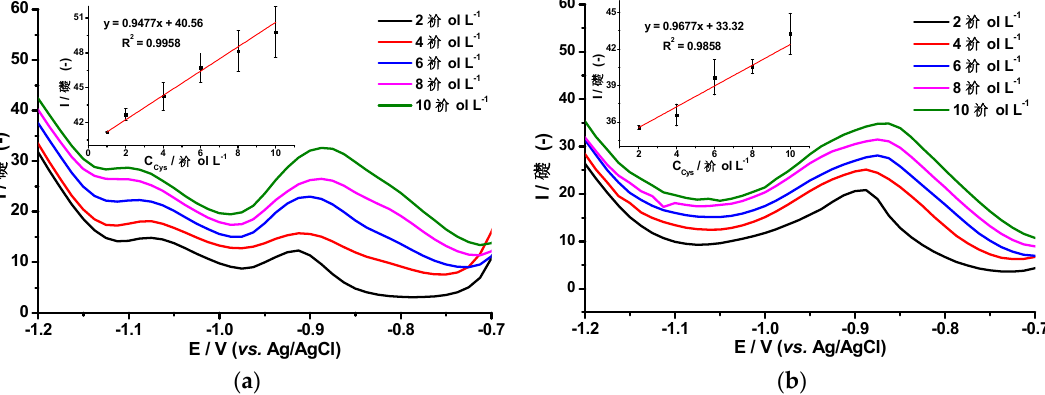
Figure 5. VPD responses of ( a ) AgHgNf/Cu electrode and ( b ) AgBiNf/Cu electrode in the Brdi č ka supporting electrolyte after addition of 2 to 10 µ mol L − 1 of l -cysteine. Inset: Calibration curves of l -cysteine at the modified electrodes. 25 mV s − 1 scan rate.